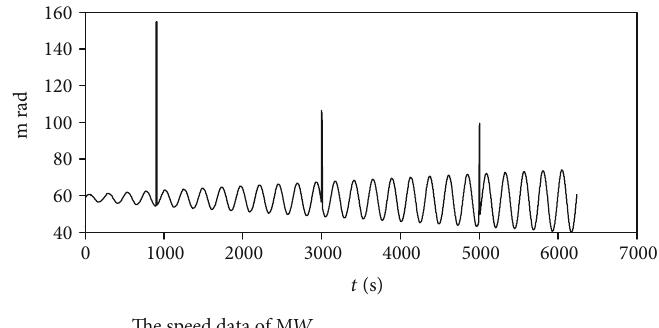
Figure 1: The change curves of momentum wheel speed.